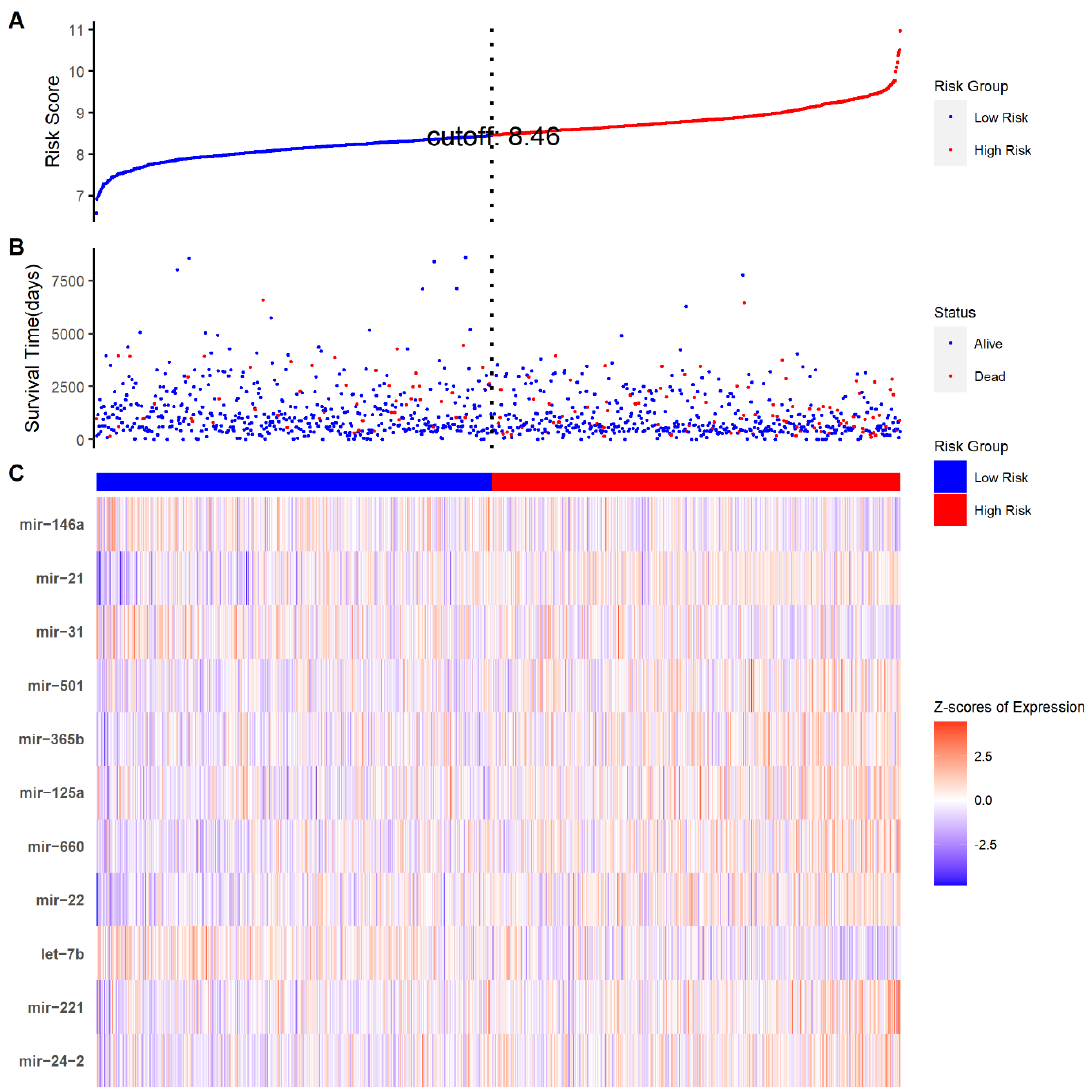
Figure 3. Risk score distribution and TRM expression heat map in TCGA-BRCA dataset. ( A ) Risk score distribution where blue dot signifies low-risk group and red dot signifies high-risk group. Vertical dotted lines indicate the cut-off point for median risk score. ( B ) Survival time and status for all patients. ( C ) Heat map of the eleven selected TRM expression in the TRM signature.